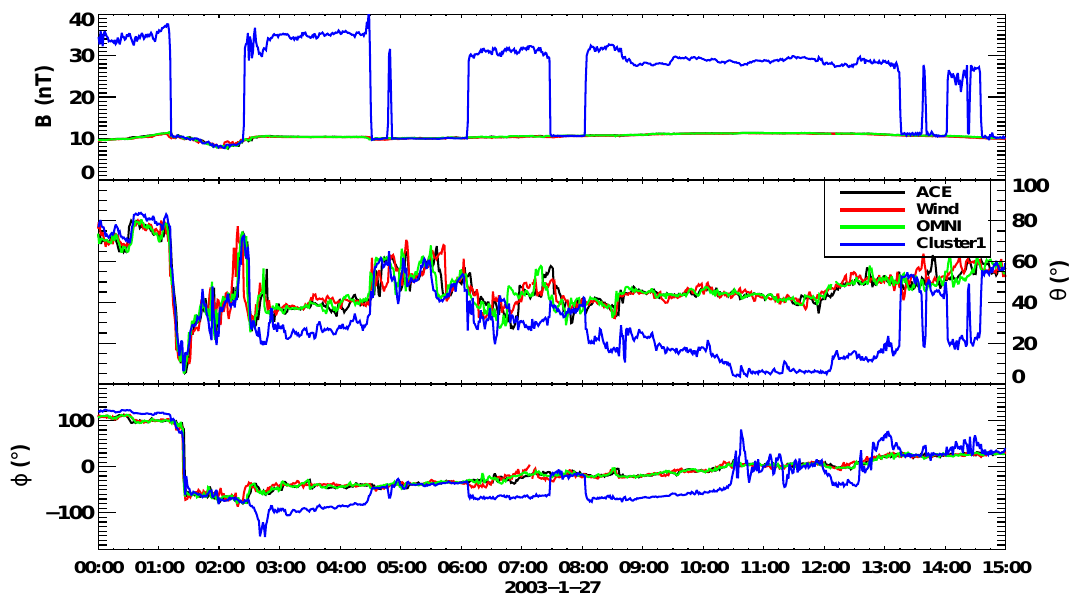
Fig. 2. Magnetic field amplitude and direction during the 27 January 2003 MC from ACE (black), Wind (red), OMNI (green) and Cluster 1 (blue) data sets – see text for definition of θ and ϕ